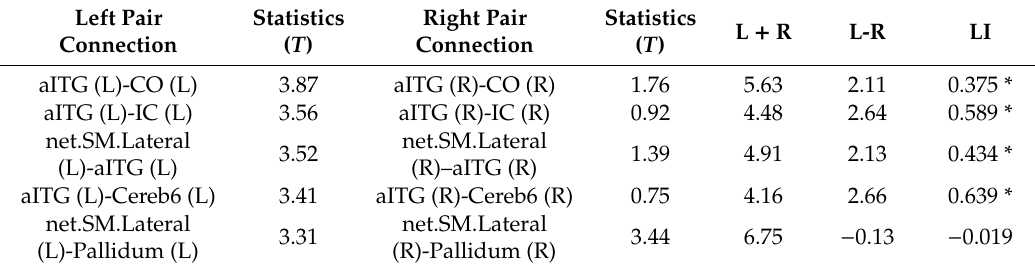
Table 5. Lateralization index on Mouth > Nose contrast in each